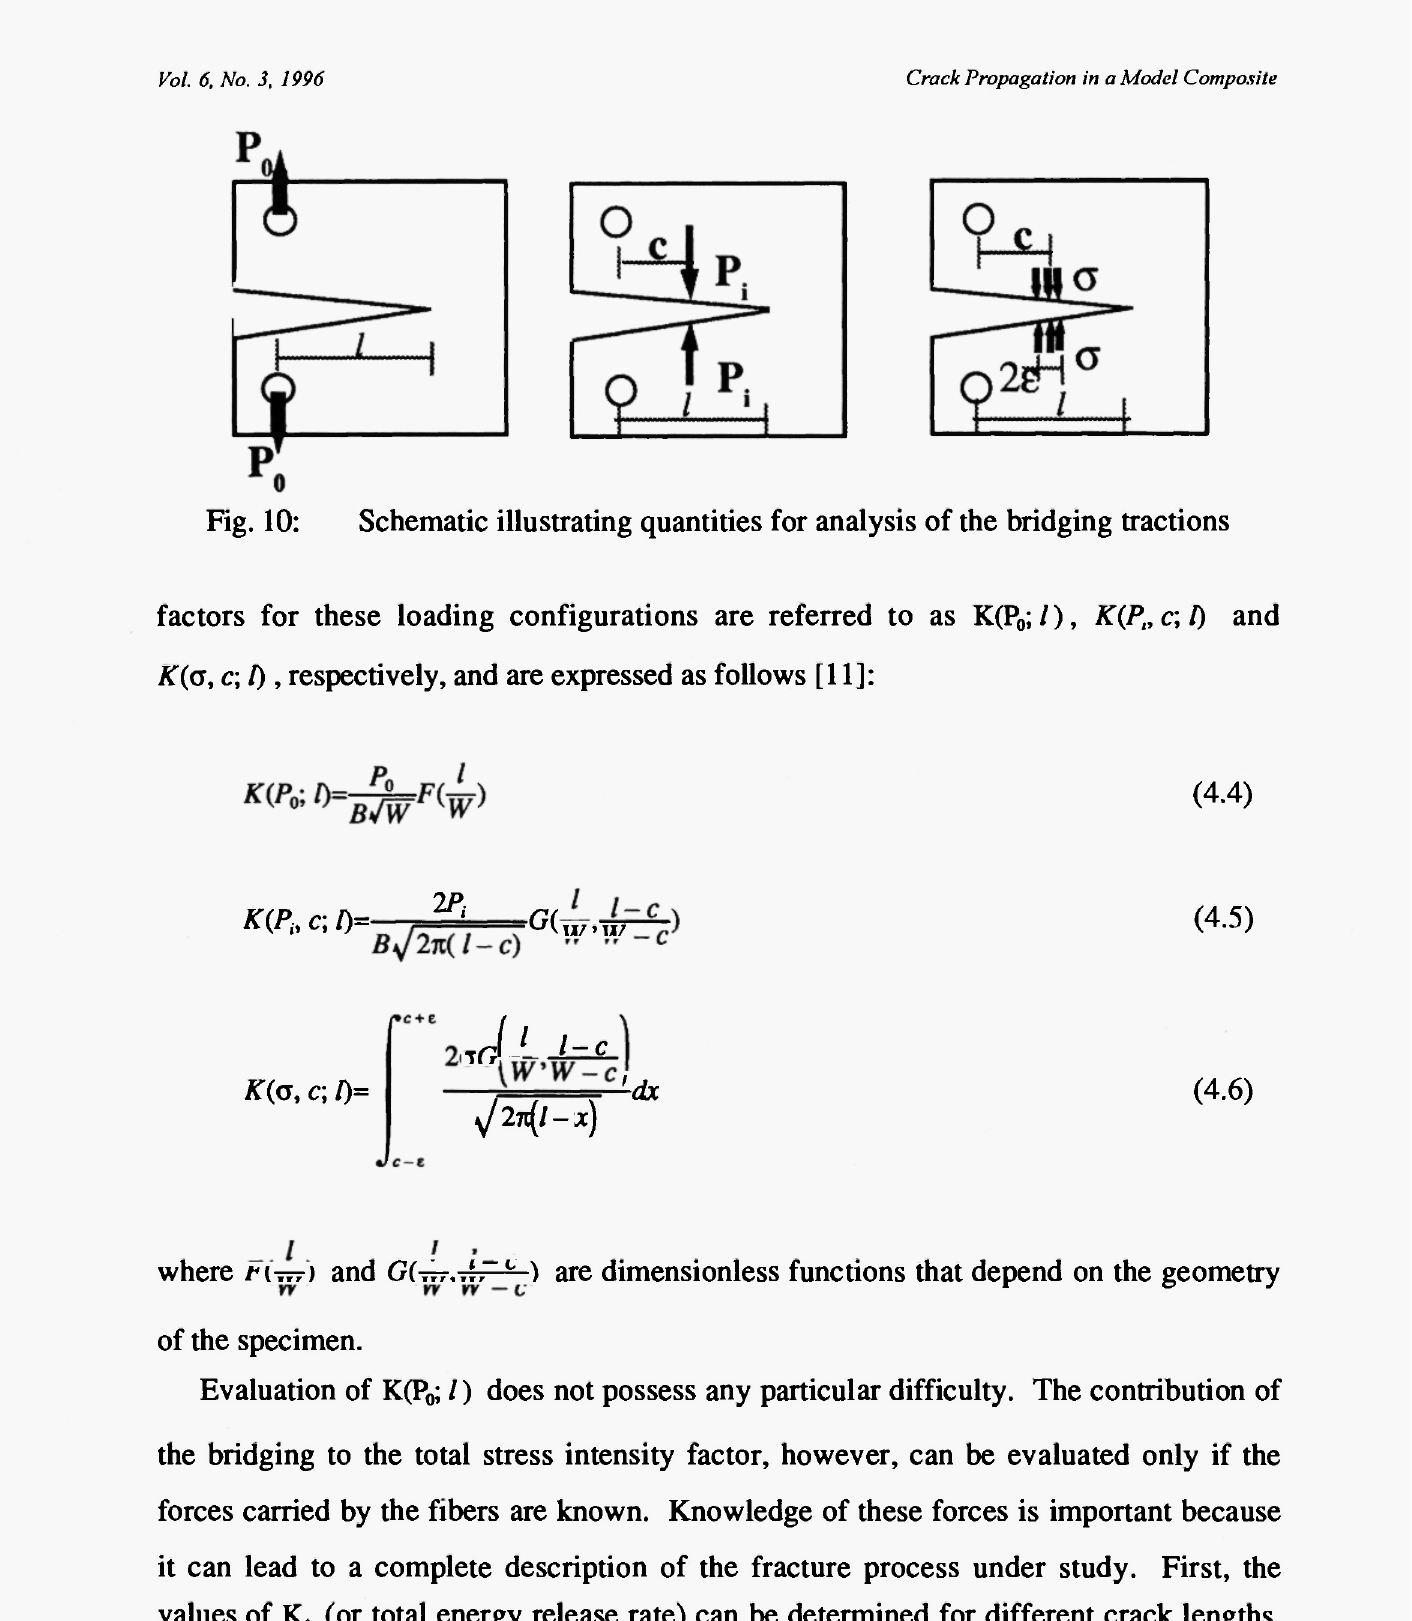
Fig. 10: Schematic illustrating quantities for analysis of the bridging tractions factors for these loading configurations are referred to as K(P